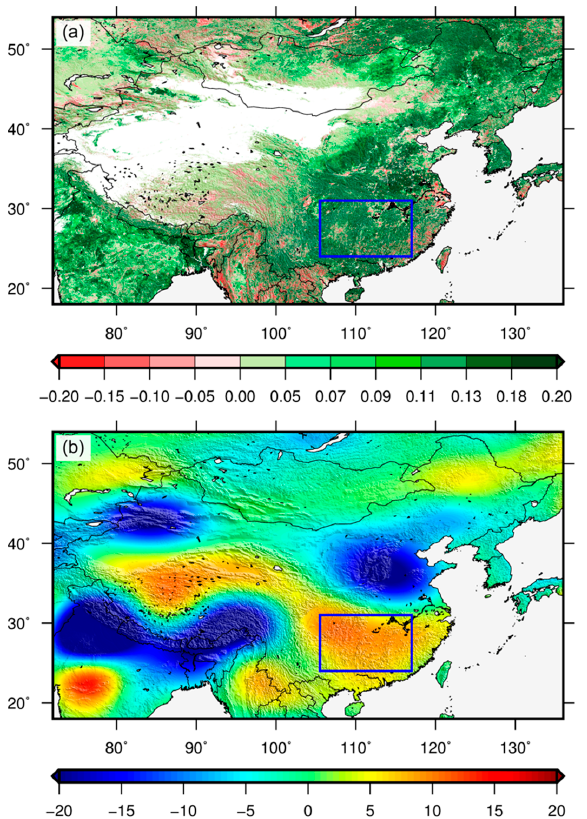
Figure 1. Trends in patterns of leaf area index (LAI) ( a , unit: 10 − 1 m 2 /m 2 /yr) and mass ( b , unit: mm/yr) in equivalent water heights from January 2003 to August 2016, as measured by moderate-resolution imaging spectroradiometer (MODIS) and Gravity Recovery and Climate Experiment (GRACE). The blue box denotes our study region.